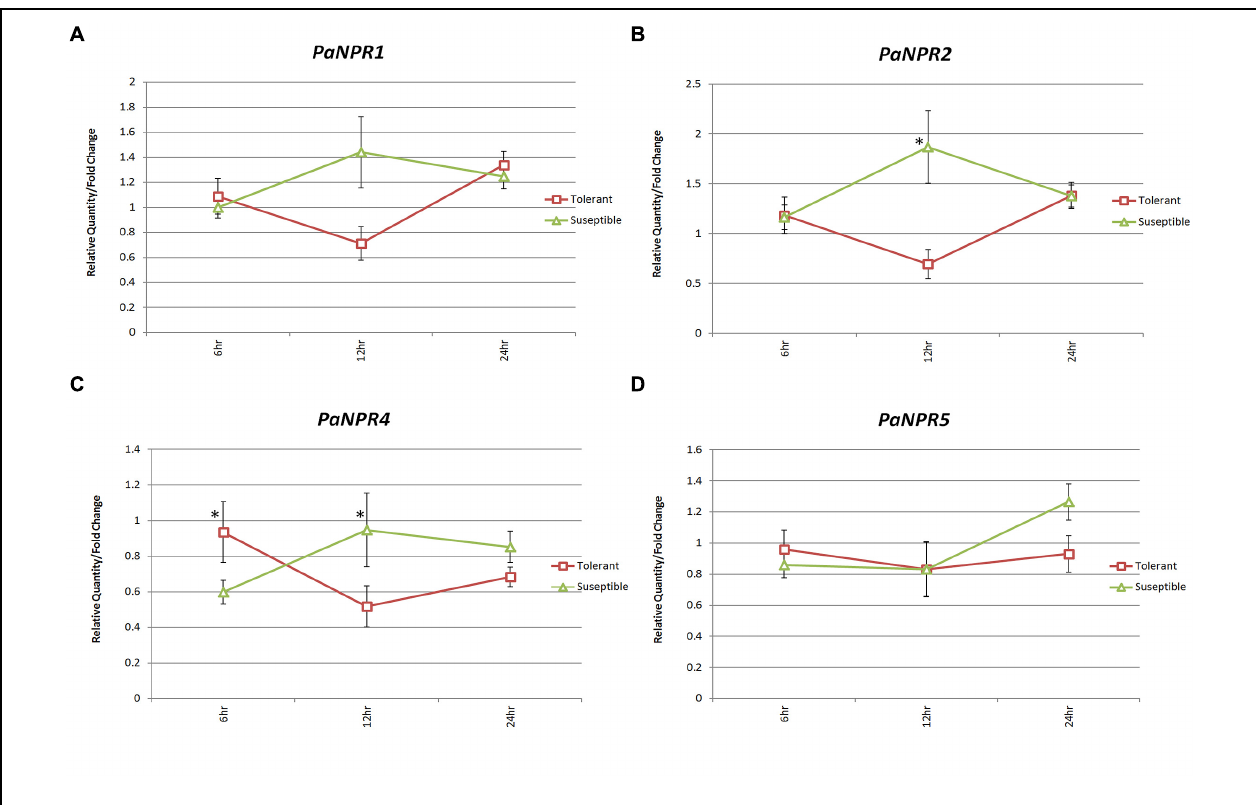
FIGURE 5 | Expression of PaNPR1 -like genes in tolerant (Dusa (cid:2) ) and susceptible (R0.12) avocado rootstocks infected with P. cinnamomi . Normalized relative quantities (fold change) for (A) PaNPR1 , (B) PaNPR2 , (C) PaNPR4, and (D) PaNPR5 were calculated using the method described by Pfaffl (2001). The response is indicated by horizontal lines (red – tolerant, green –